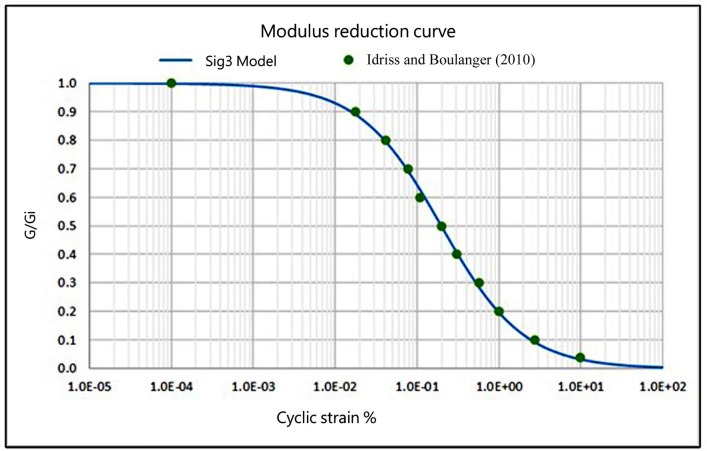
Shear modulus reduction curve.